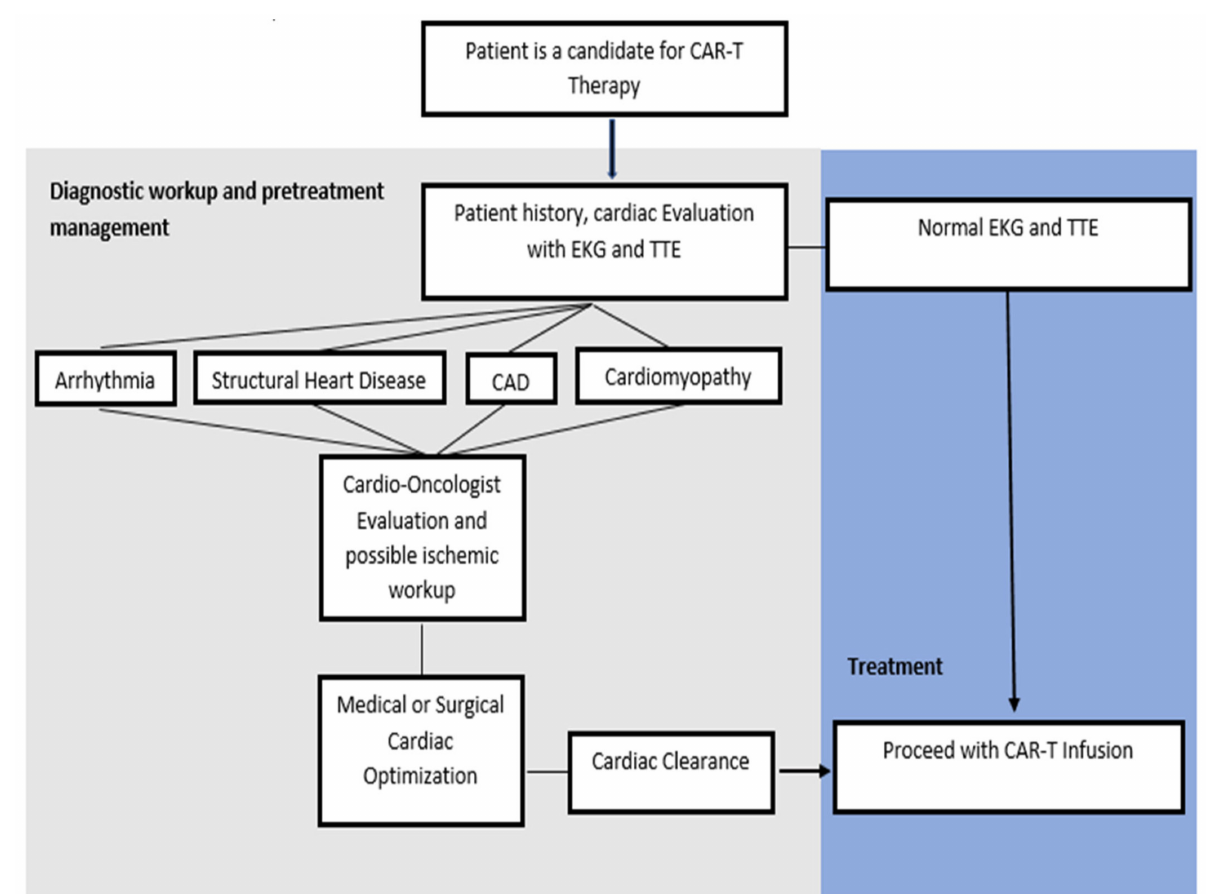
Figure 2. Pre-operative assessment. CAR-T: Chimeric antigen receptor T-cells; EKG: Electrocardiogram; TTE: Transthoracic echocardiogram; CAD: Coronary artery